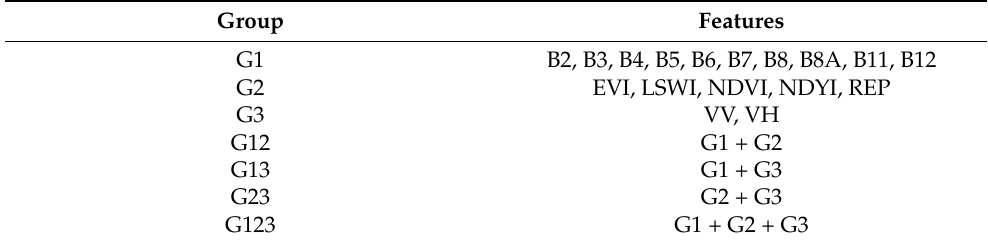
Table 4. The group of different features.